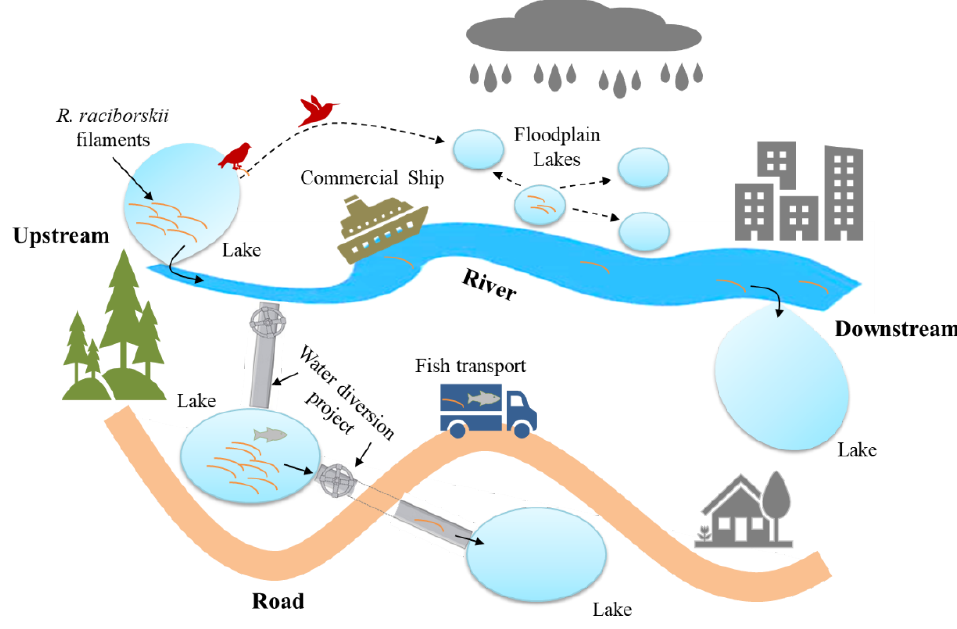
Figure 3. Probable dispersion routes for R. raciborskii.